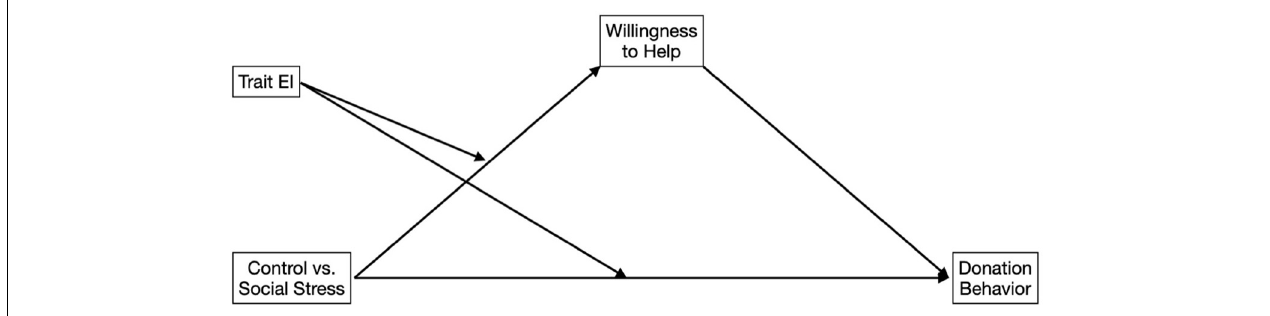
FIGURE 3 | Path of the mediation analysis. The model tests whether willingness to help mediates the effect of the independent variables on donation